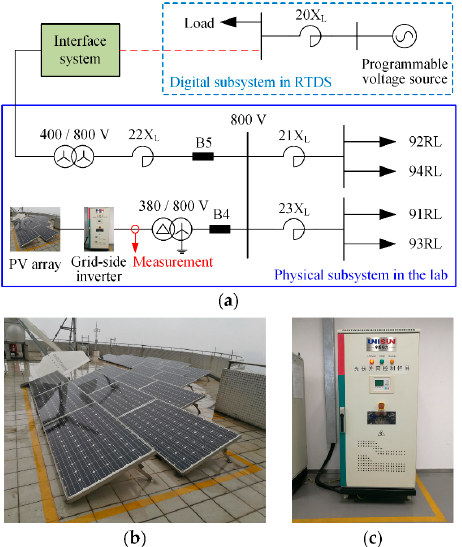
Figure 10. Digital-physical hybrid real-time simulation system used for LVRT testing of PV inverter. ( a ) System diagram; ( b ) 10 kW monocrystalline silicon PV array; ( c ) PV inverter under test.